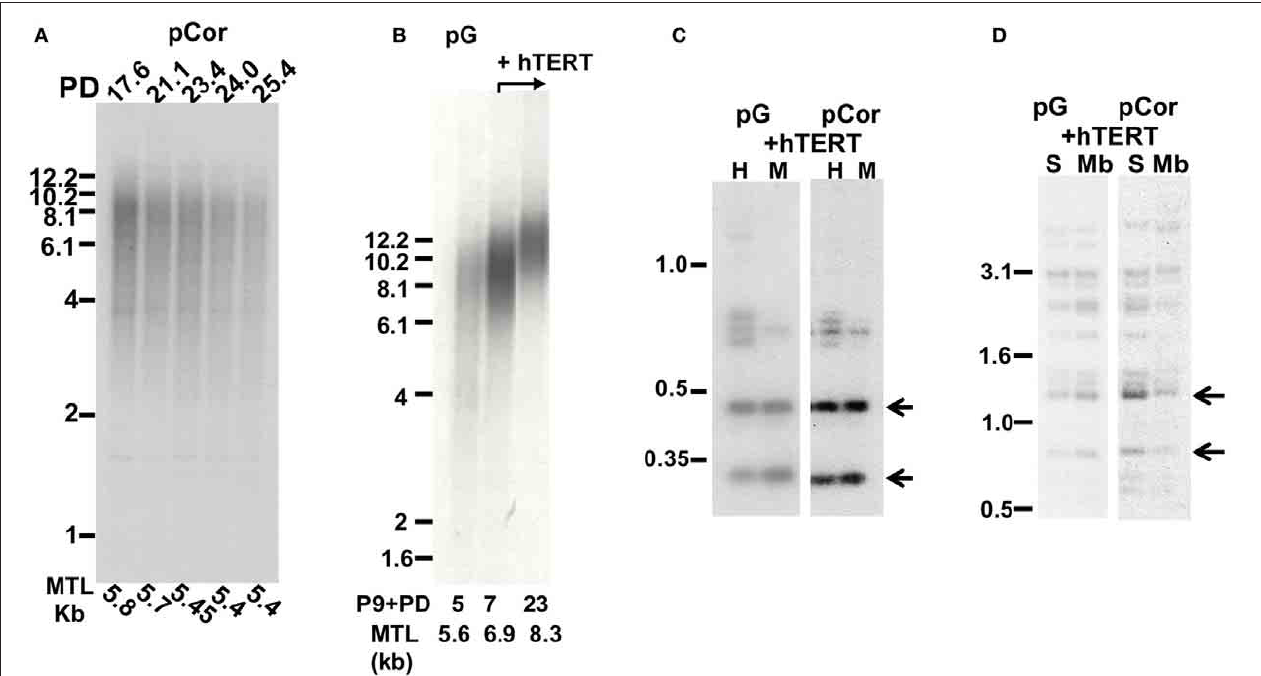
FIGURE 5 | Premature senescence is associated with short telomere length in ICF fibroblasts. (A) TRF analysis of pCor fibroblasts at different PDs (which appear above the lanes). Mean telomere length (MTL) as determined by MATELO software are indicated below the lanes. Size markers in kb are shown to the left of the blot. (B) TRF analysis of pG fibroblasts with and without expression of ectopic hTERT. The PD at which DNA was extracted from the cells and the MTL in kb as determined by MATELO software, appear below the blot. (C) Methylation analysis of subtelomeric repeats with NBL-1 probe in pG and pCor fibroblasts after